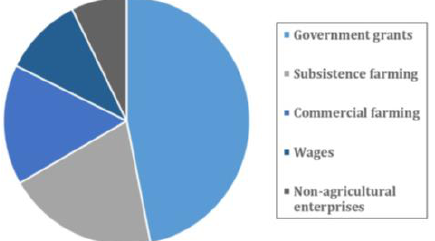
Fig. 2. Participants’ sources of income (Source: own